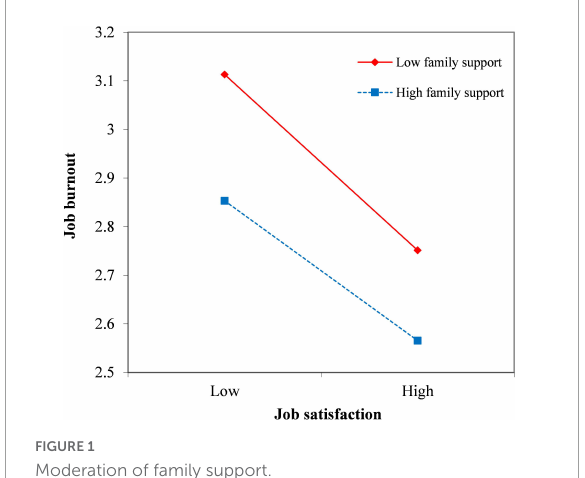
FIGURE1 Moderation of family